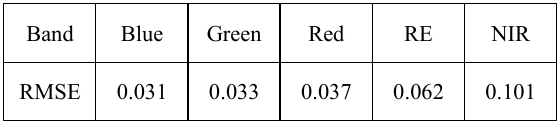
Table 1. RMSE of reflectance for the RCOP result compare to the validation